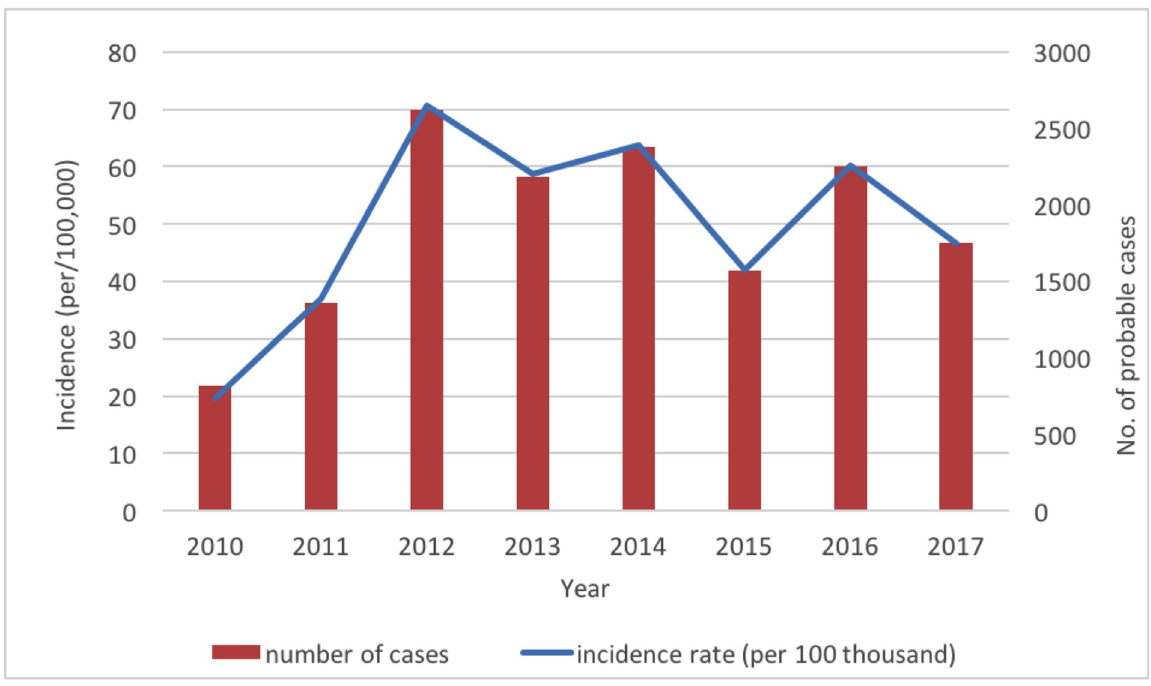
Fig 1. Annual incidence and number of probable cases of HFMD in Neijiang, China, 2010–2017.